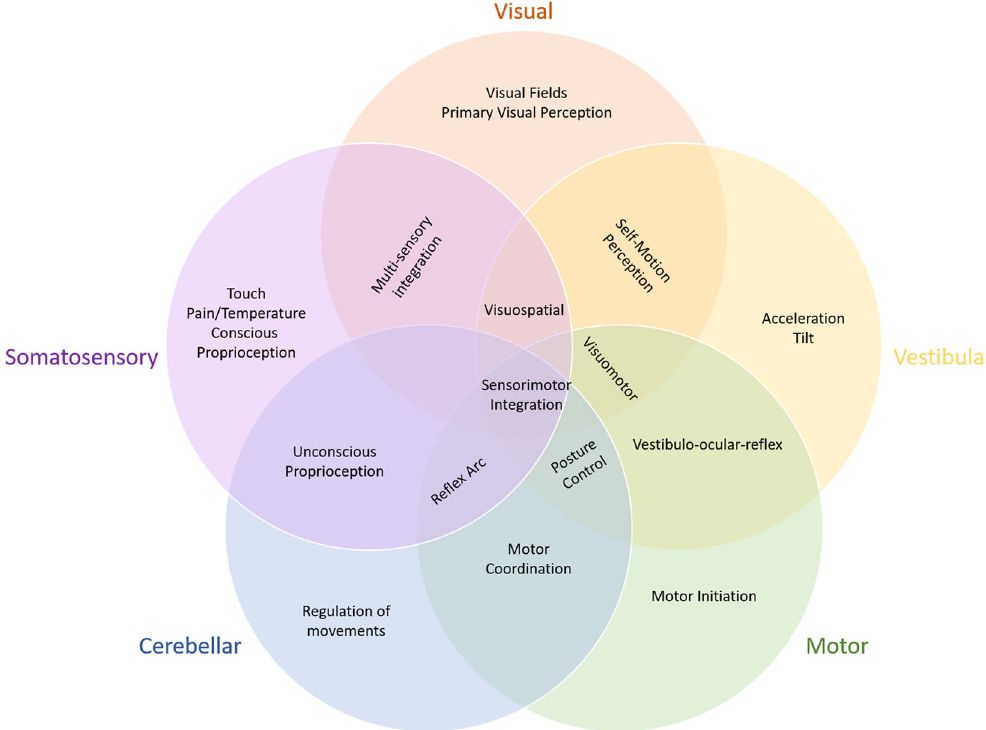
Fig. 2 CNS regions impacted during space fl ight. A summary fi gure illustrating the CNS regions believed to be impacted during space fl ight, including both primary CNS regions and the integration of those regions during higher-level